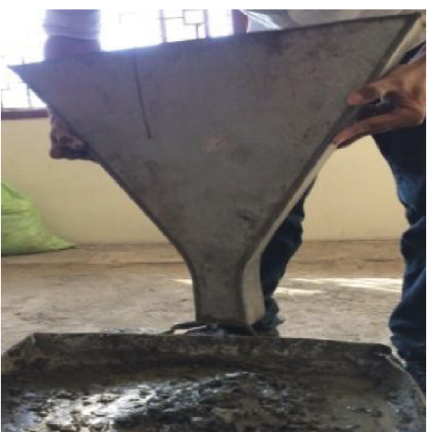
Figure 6: V-funnel